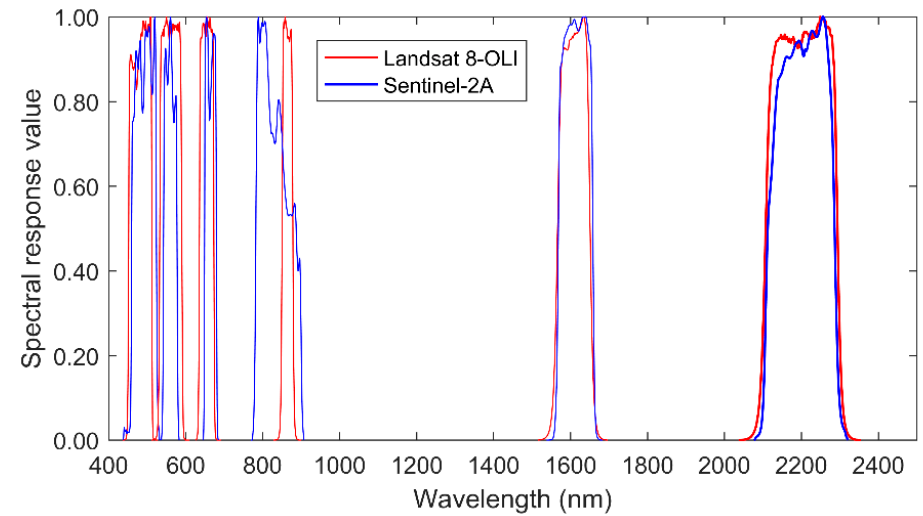
Figure 2. The spectral response of Sentinel − 2A and Landsat − 8 OLI.